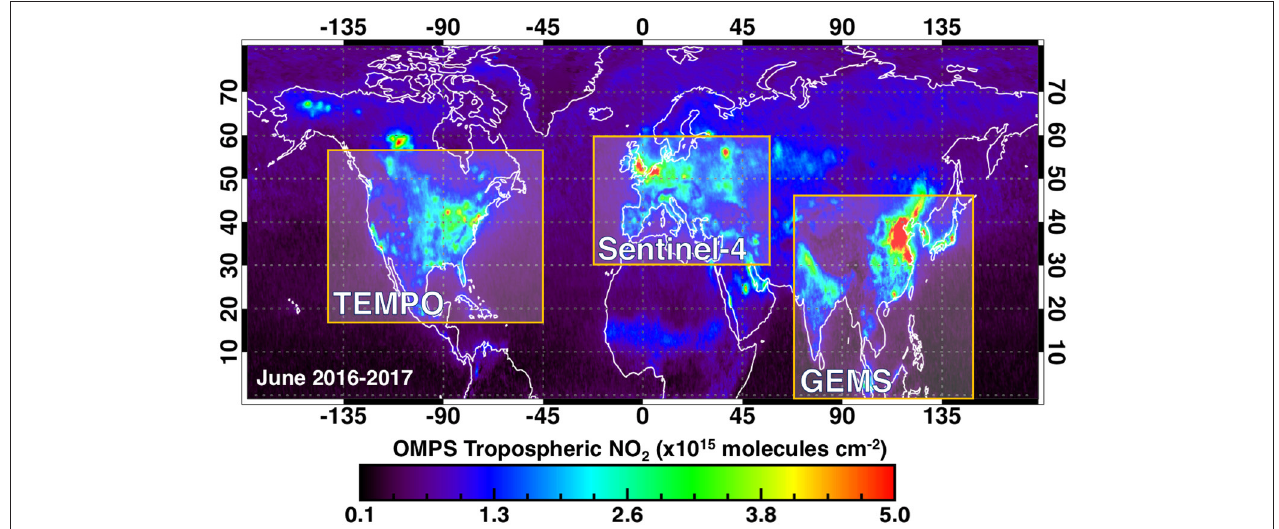
FIGURE 1 | Global map of OMPS NM tropospheric NO 2 vertical columns for June 2016 and June 2017 averaged to 0.25 ◦ × 0.25 ◦ with the overlaid approximate spatial coverages of the planned GEO platforms: TEMPO over North America, Sentinel-4 over Europe, and GEMS over East